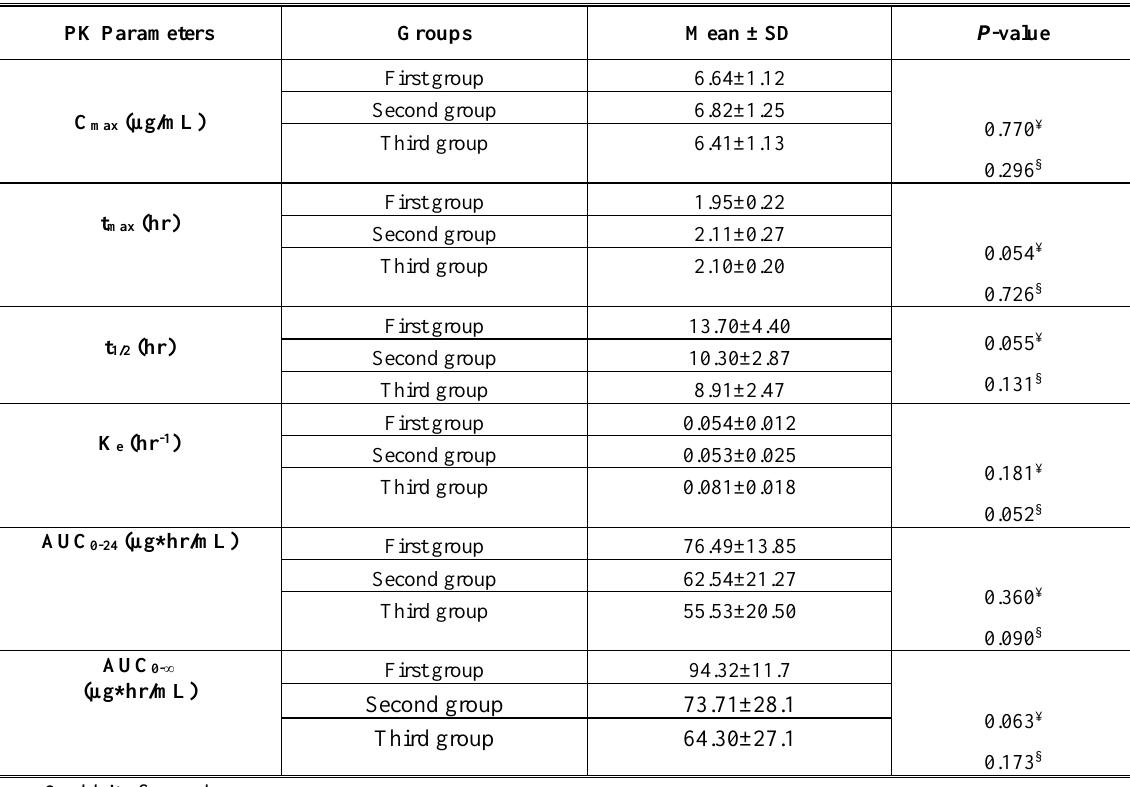
Table 1. Pharmacokinetic Parmeters of CBZ without VAL (First group) and with VAL (Second and Third groups) in